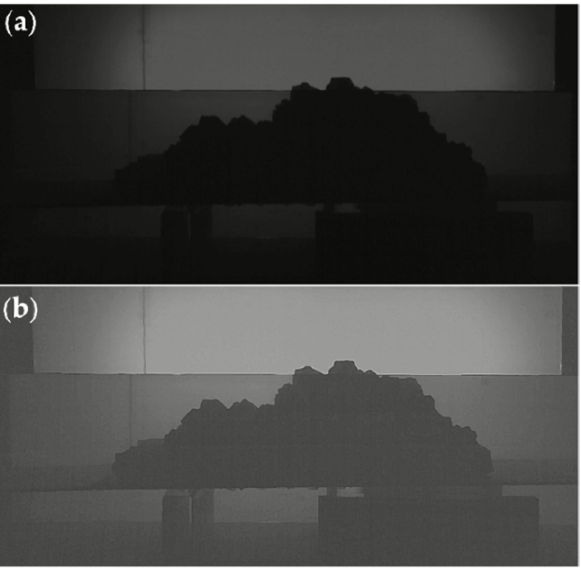
Figure 3. Image processing enhancements: ( a ) input image; ( b ) enhanced